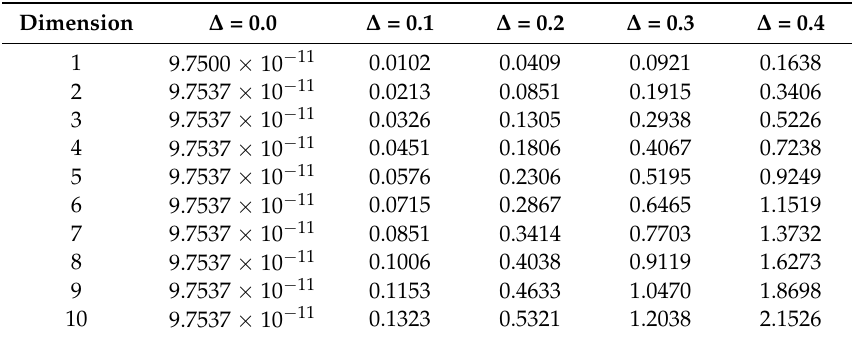
Table 2. Cyber Deep Learning Cluster